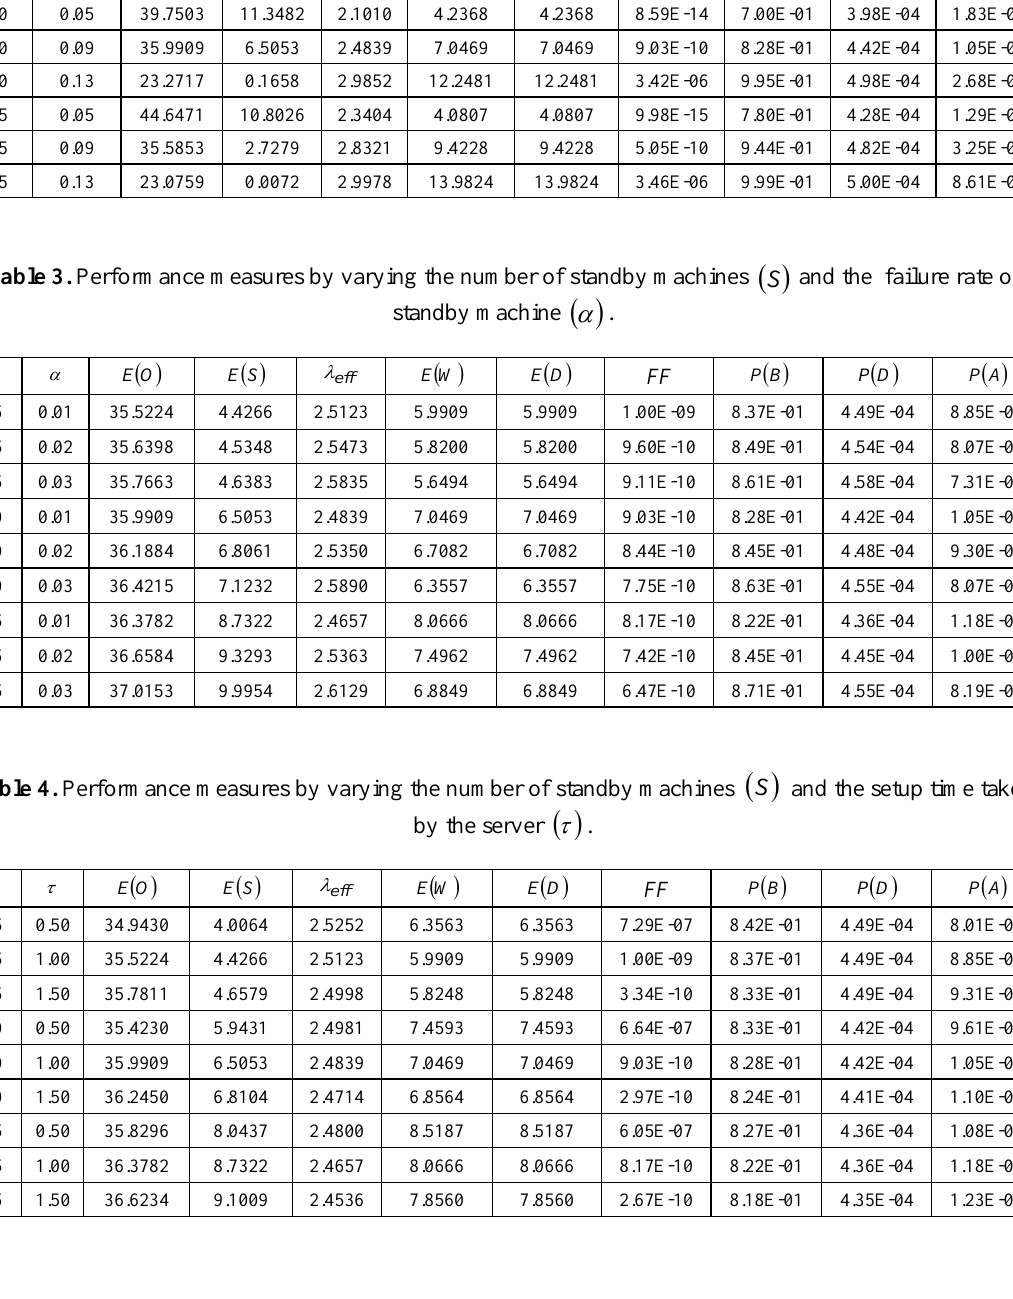
Table 2. Performance measures by varying the number of operating machine ( ) M and the degraded failure